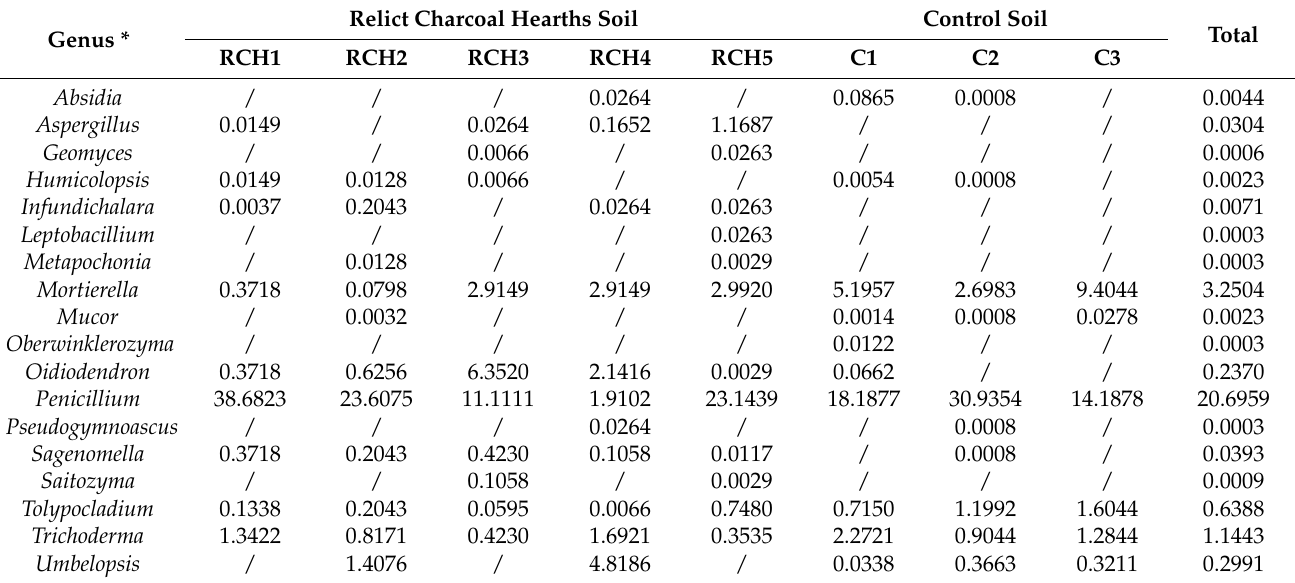
Table 7. The dominance ( Y ) values of culturable fungal genera from relict charcoal hearths (RCH) soil and control soil. Genus